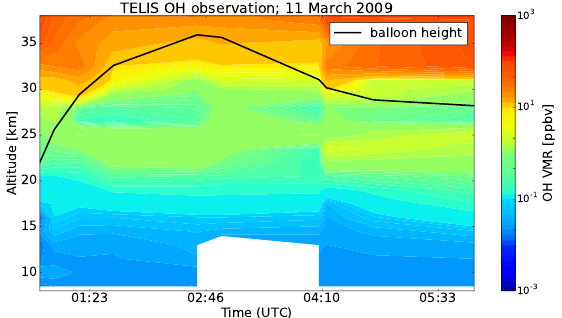
Figure 16. OH VMR profiles estimated from TELIS measurements on 11 March 2009. Here, the balloon height is indicated by a solid black